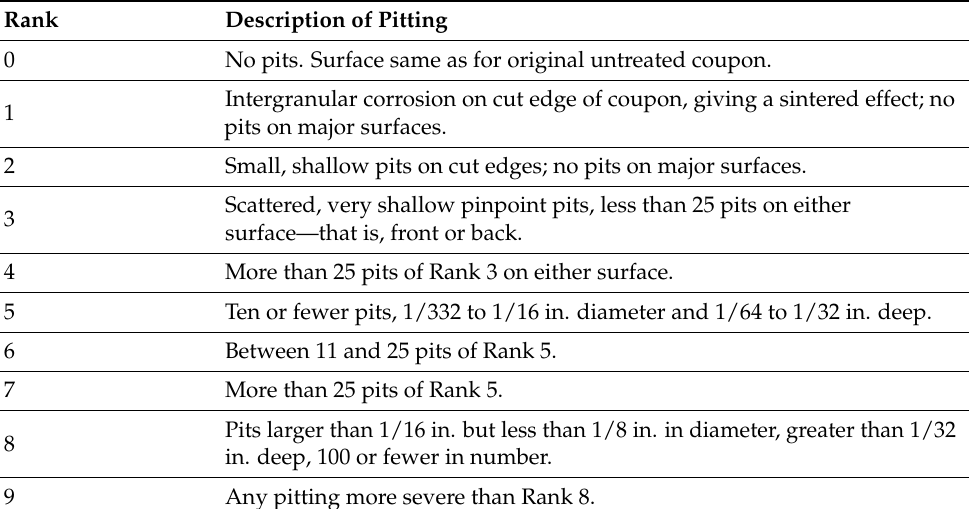
Figure 3. Fractographies of the tested graduated cylinders (20 × ). The yellow arrows show the presence of pitting according to Smith’s criterion. Table 2. Smith’s criterion for assessing corrosion levels.